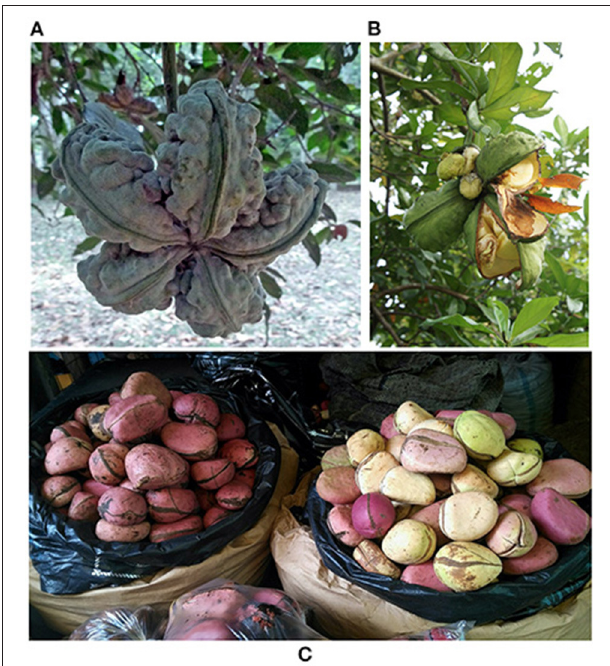
FIGURE 4 | Kola (Cola acuminata and C. nitida). (A) Kola fruit pods. Source: Scamperdale. CC BY-NC. (B) Split kola fruit pods. Source: M. Hermann. CC BY-SA 3.0. (C) Kola nuts for sale at a Nigerian market. Source: N. Chinenye. CC BY-SA